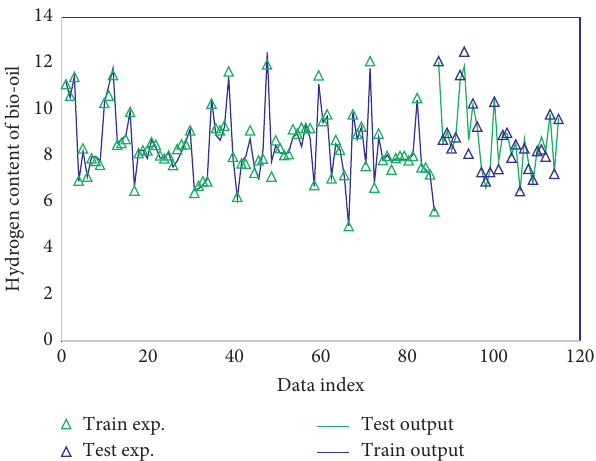
exp.Train Test Figure 3: Observational analysis to compare actual output data and their corresponding modeling values in the test and training phases.